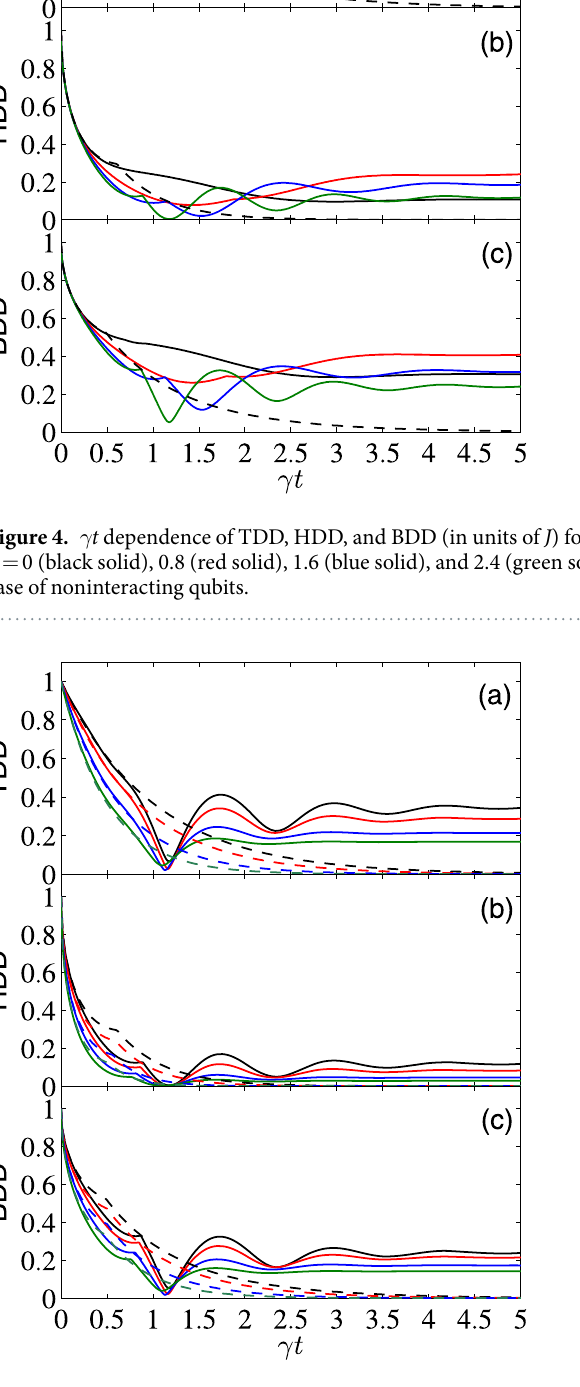
Figure 5. γ t dependence of TDD, HDD, and BDD (in units of J ) for the initial state φ + , with B = 2.4, Δ = 1, and = n 0 , 0.1, 0.3, and 0.5 (solid curves from top to bottom). Moreover, the dashed lines show the corresponding plots for noninteracting